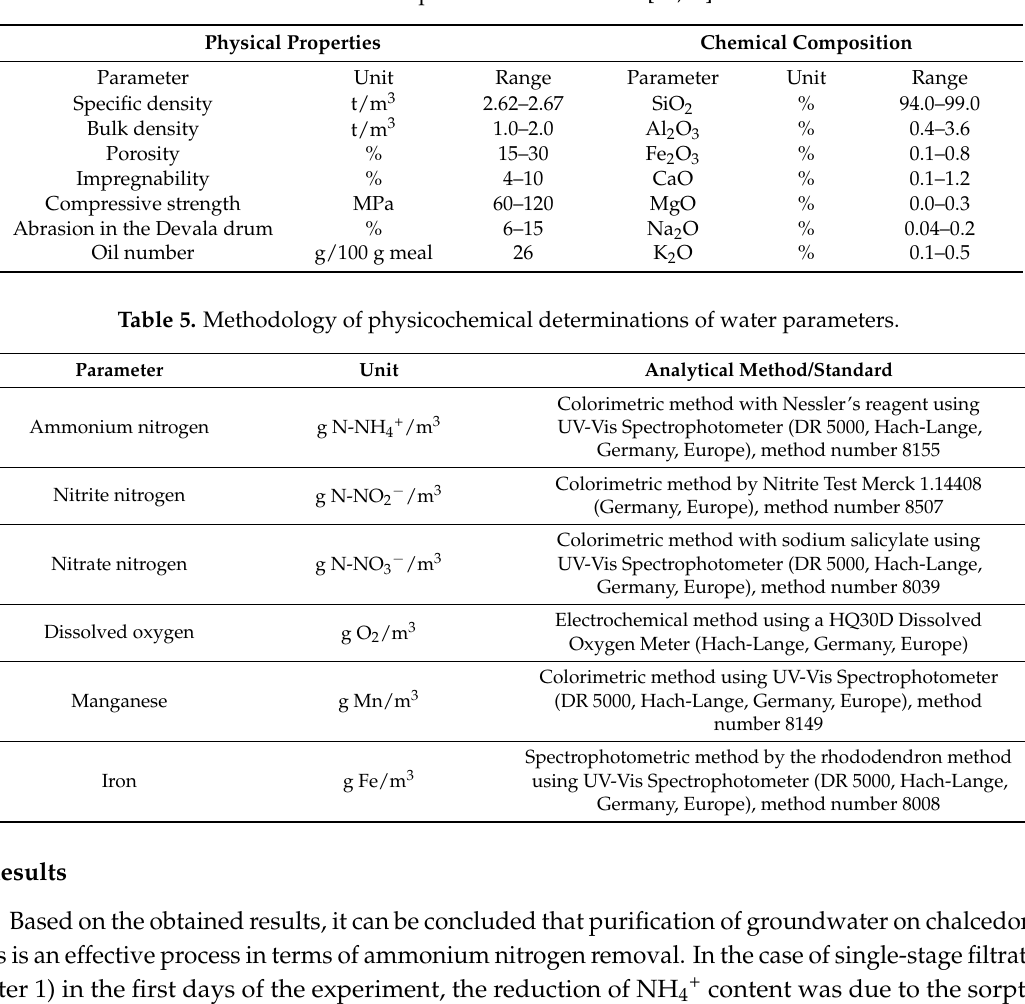
Table 4. Properties of chalcedonite [34,35].